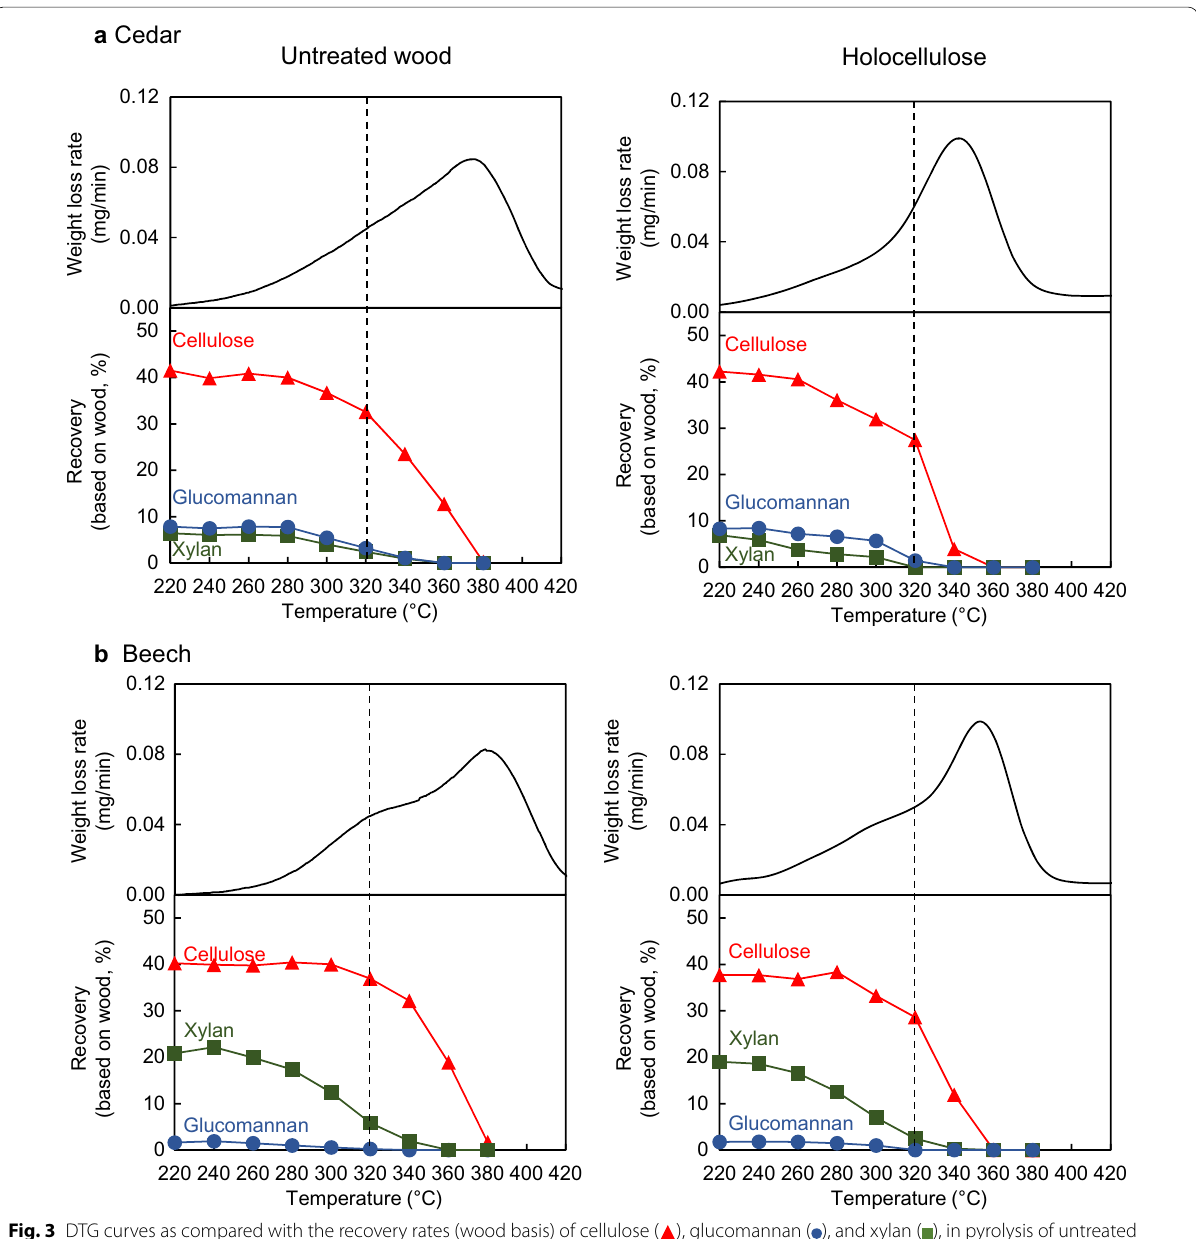
Fig. 3 DTG curves as compared with the recovery rates (wood basis) of cellulose ( ), glucomannan ( ), and xylan ( ), in pyrolysis of untreated wood and holocelluose. Dashed lines at 320 °C are inserted to facilitate comparison. Results of untreated wood were taken from Wang et al.